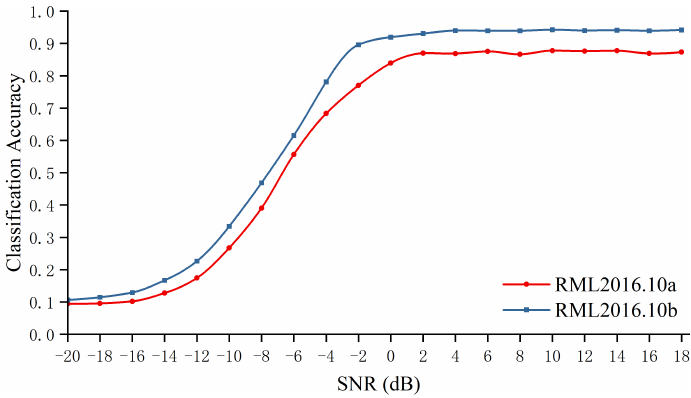
Figure 17. Classification accuracy of different datasets vs.